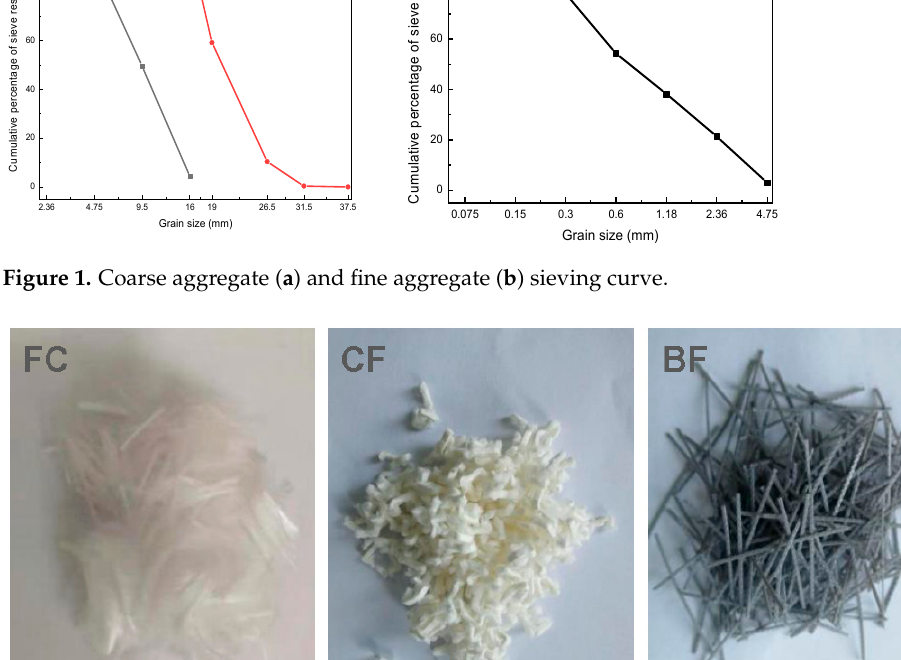
Figure 1. Coarse aggregate ( a ) and fine aggregate ( b ) sieving curve.